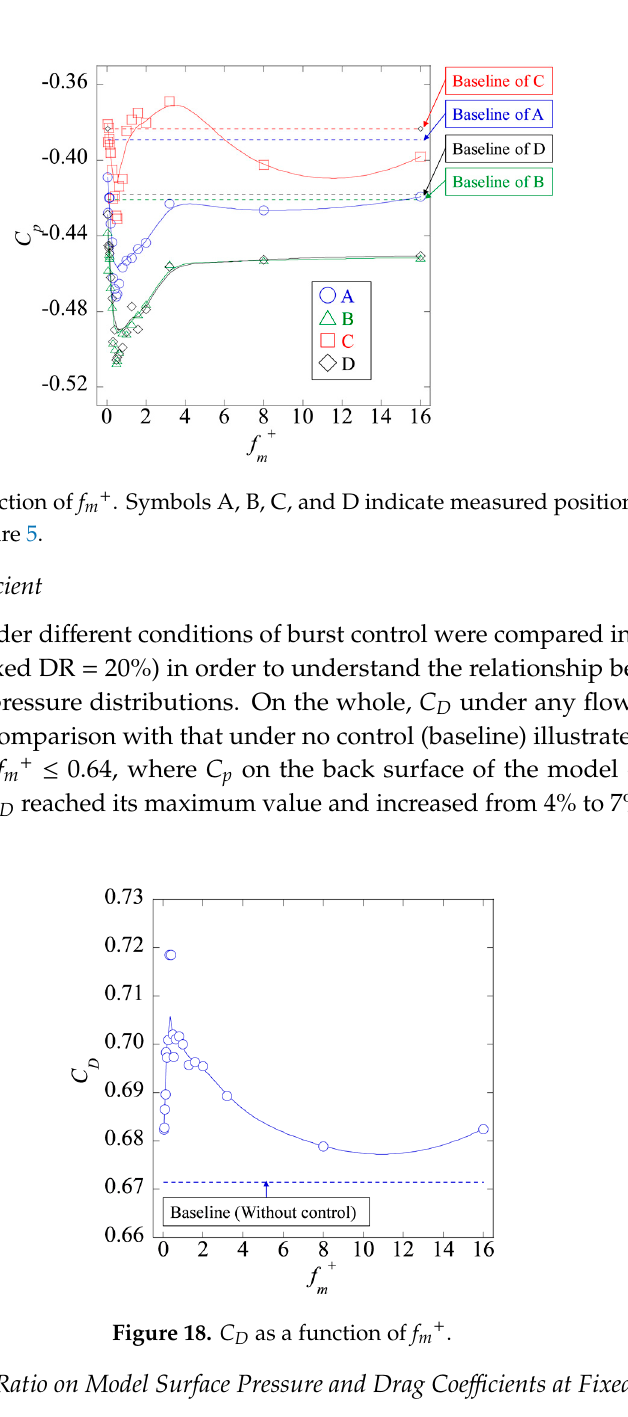
Figure 16. C p as a function of ( a ) y / D at z / D = 0.0, and ( b ) z / D at y / D = 0.0.